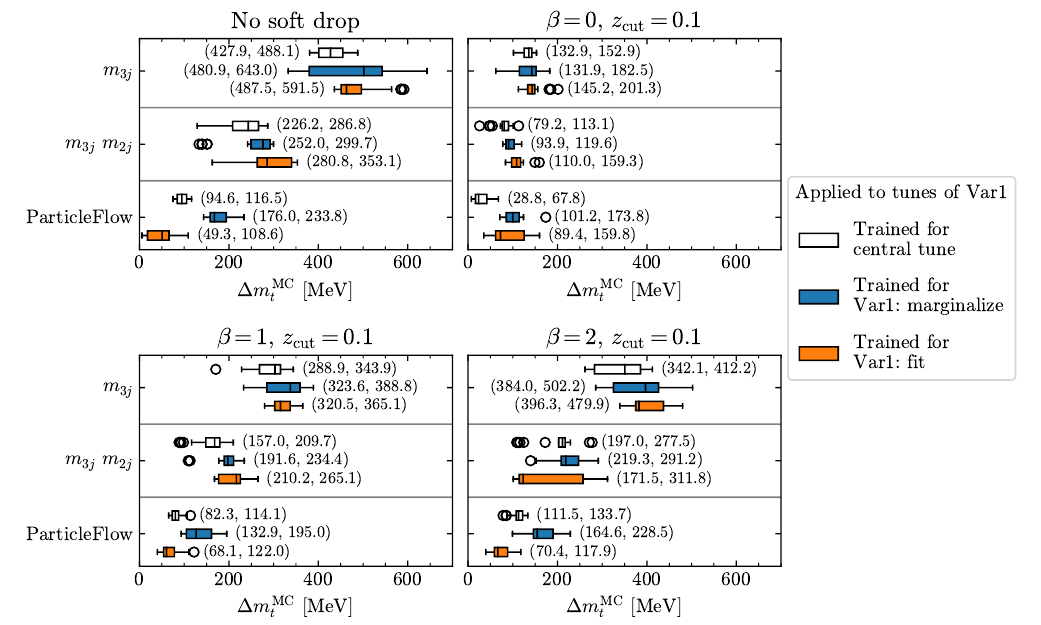
Figure 12. Results testing the input data for DCTR to use as well as the method of inference on VAR1. Including both m 3 j and m 2 j along with the low-level information captured by ParticleFlow results in the lowest uncertainty. DCTR works best when inferring all of the tune parameters (orange) as opposed to marginalizing over them